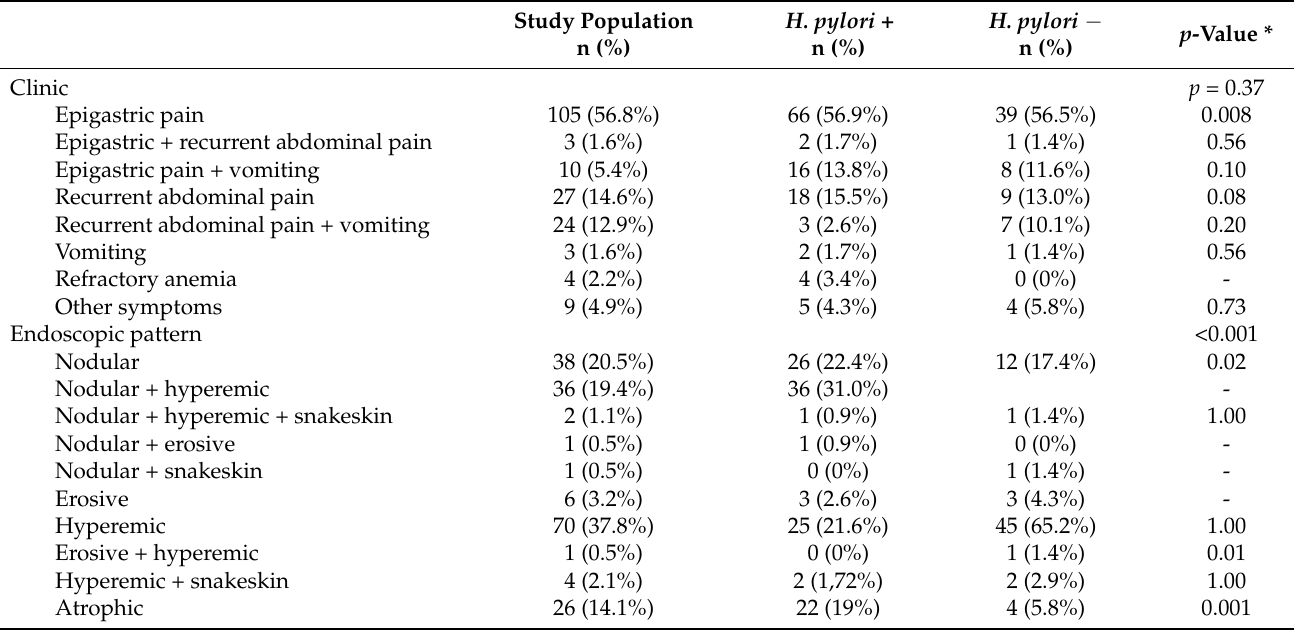
Table 3. Clinical presentation symptoms and endoscopic patterns.